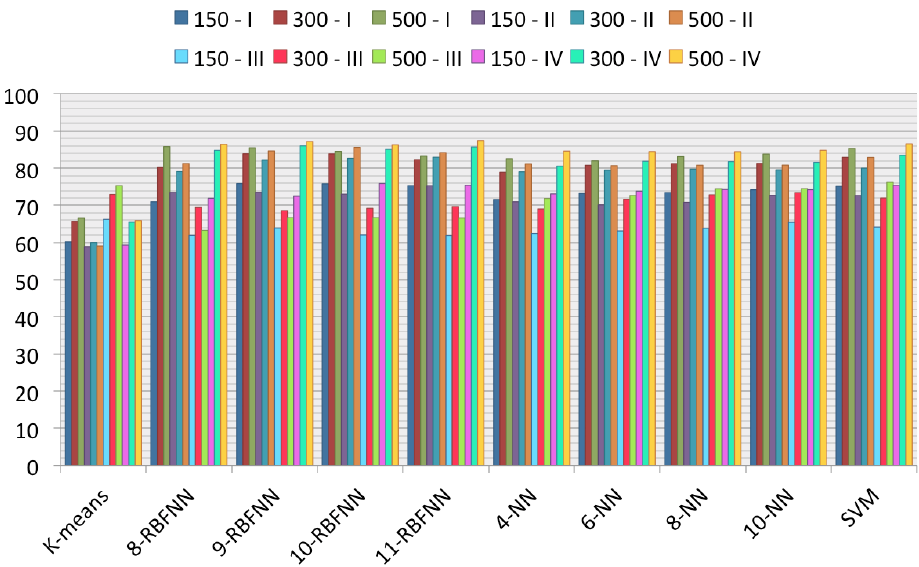
Figure 16. Overall success rates for the mean shift-filtered patches depending on the classifier (horizontal axis), the patch size (150, 300 or 500) and the parameters set (I, II, III or IV; defined in Section